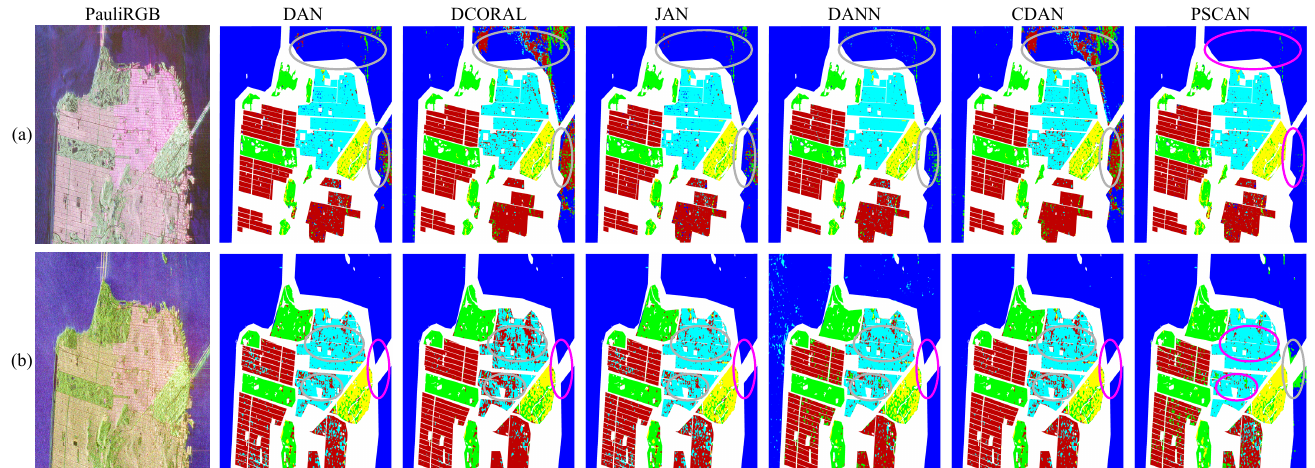
Figure 10. Comparison of the whole map classification results on the San Francisco area when